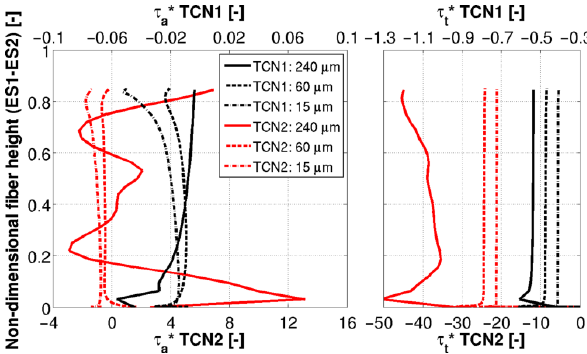
Figure 11. Variation of non-dimensional axial ( left ) and tangential ( right ) shear stress along the fiber due to etching for TCN1 and TCN2 cases. Intact fiber: 240 μm; etched fiber: 60 μm and 15 μm.